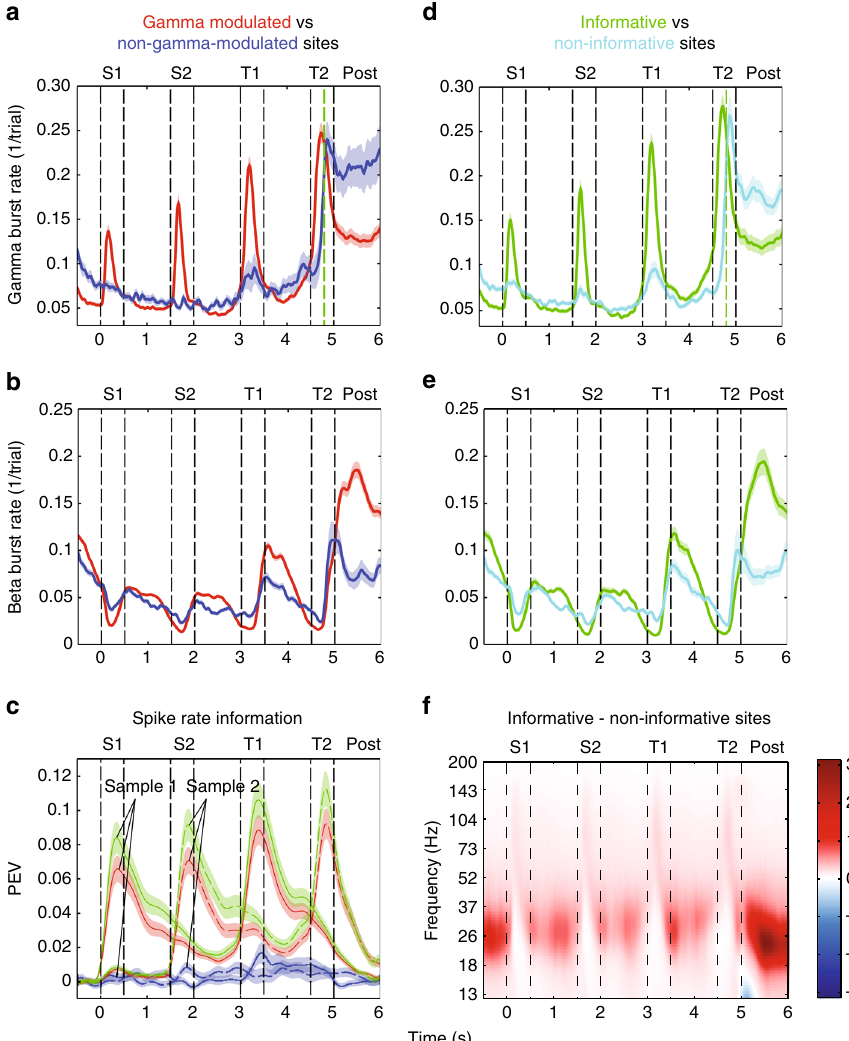
Fig. 3 Burst rates and information. All plots show the mean estimates during correct trials with matching test sequences, and 1 s of post-trial ( fi rst 1000 ms after T2 offset on correct match trials, vertical green dotted line corresponds to the average time of response on these trials) activity. a Gamma burst rate for gamma-modulated (red, n = 160) and non-modulated (blue, n = 28) sites. b Same as in a but for beta burst rates. c PEV information about the identity of sample 1 (S1, solid lines) and sample 2 (S2, dotted lines) conveyed by fi ring rates in non-gamma-modulated (blue), gamma-modulated (red), and informative (sites containing at least one unit with signi fi cant PEV (Methods section), green) sites. d Same as in a but for informative (green, n = 130) and non-informative (light blue, n = 58) sites. e Same as b but for informative and non-informative sites. f Spectrogram showing average amplitude difference between informative and non-informative sites. T1 and T2 refer to the fi rst and second test object, respectively. Error bars/shading correspond to